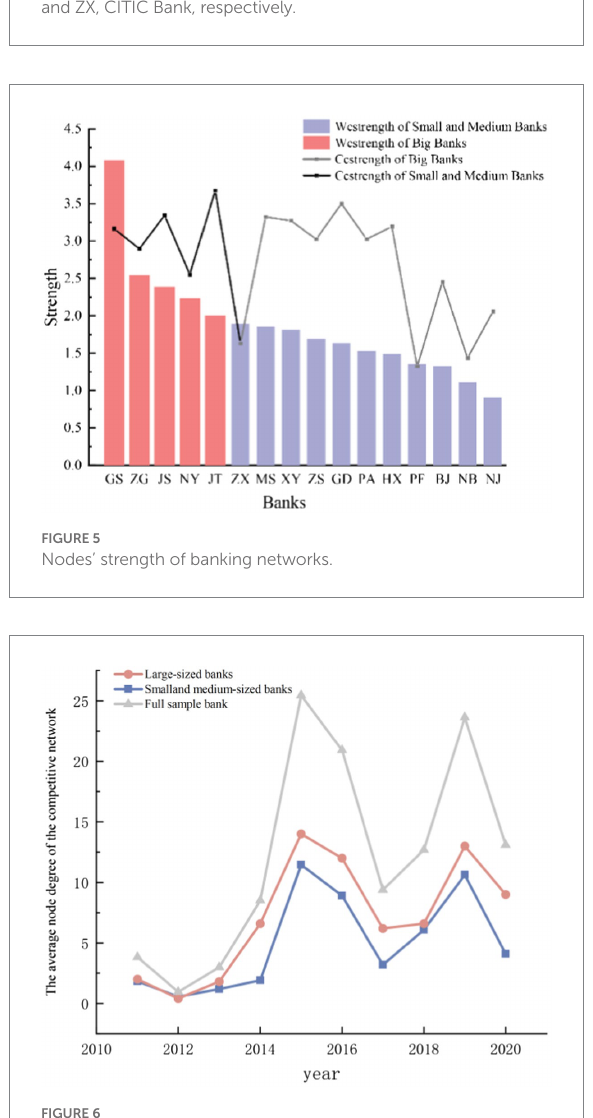
FIGURE 6 The average node degree of each sample’s competition